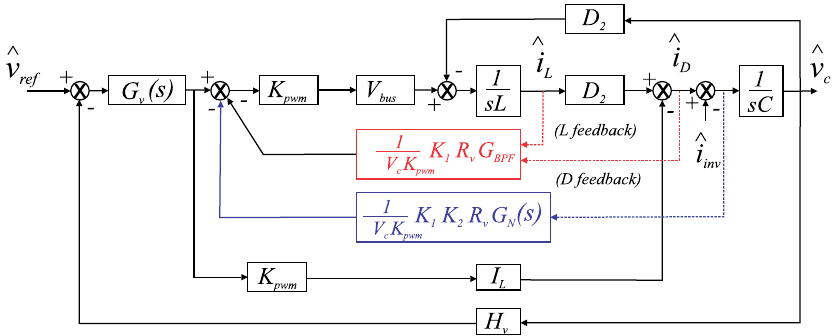
Figure 26. BPFICF with parallel impedance loop.